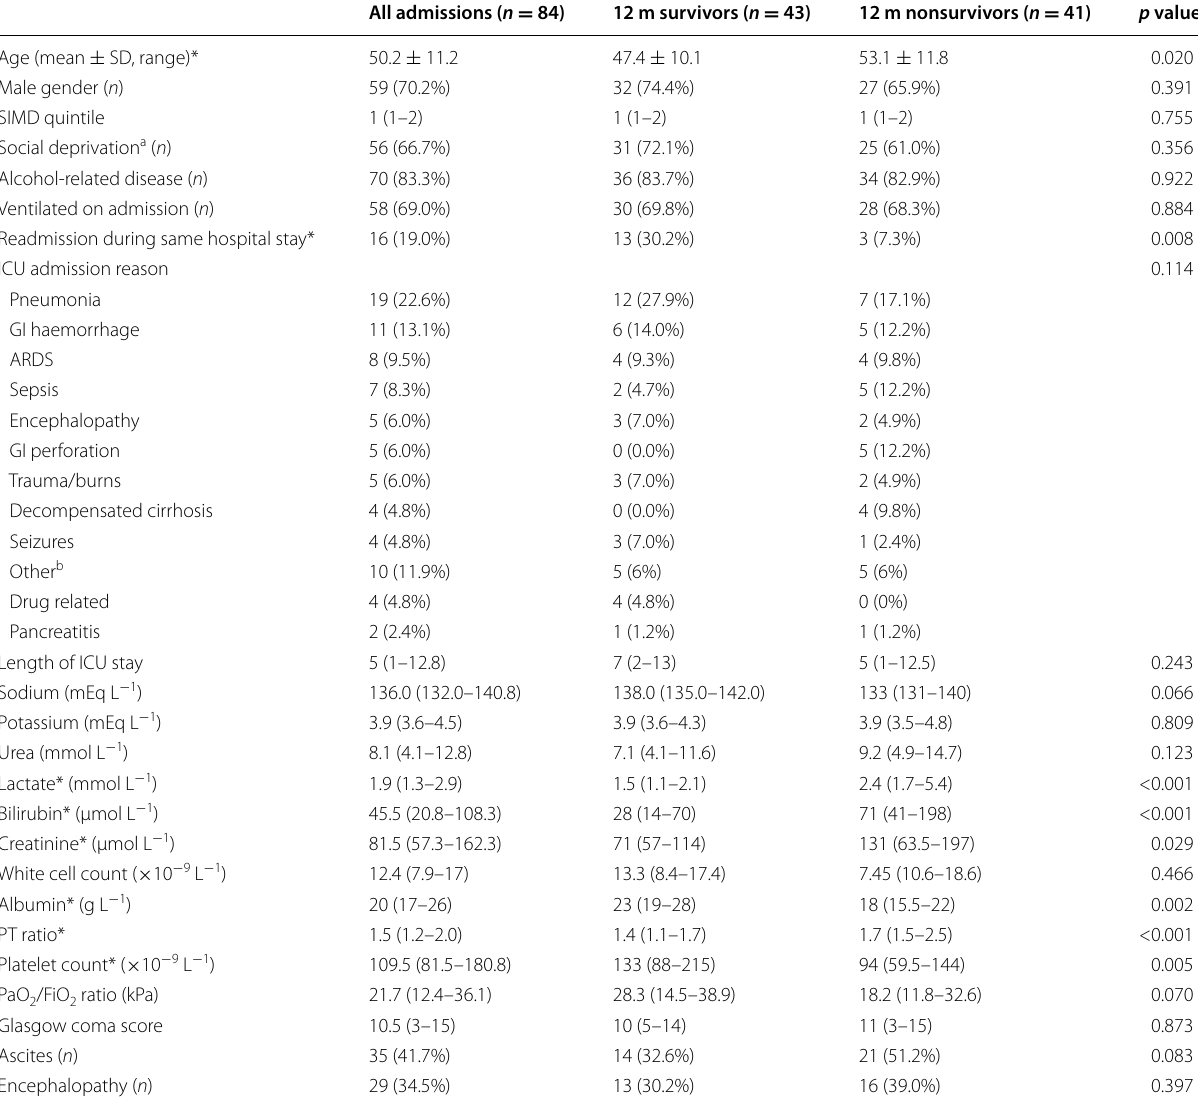
Table 1 Clinical characteristics and predictors of 12-month mortality in 84 admissions to a general ICU with a diagnosis of